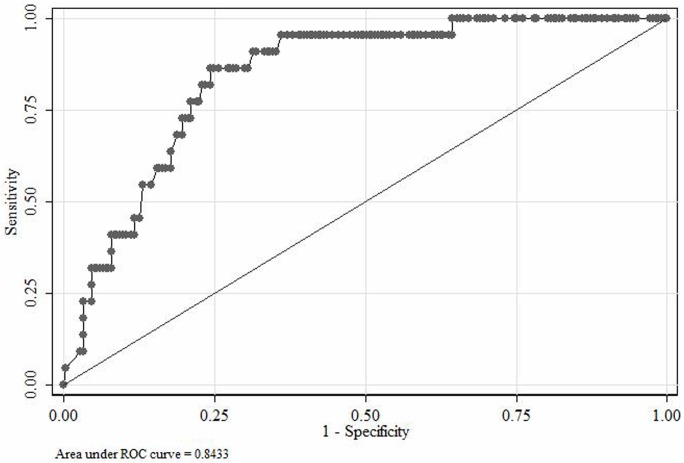
Significant GM cut-off on the basis of AspICU algorithm (for calculation proven and putative IA cases are taken as one group whilst combining others together).